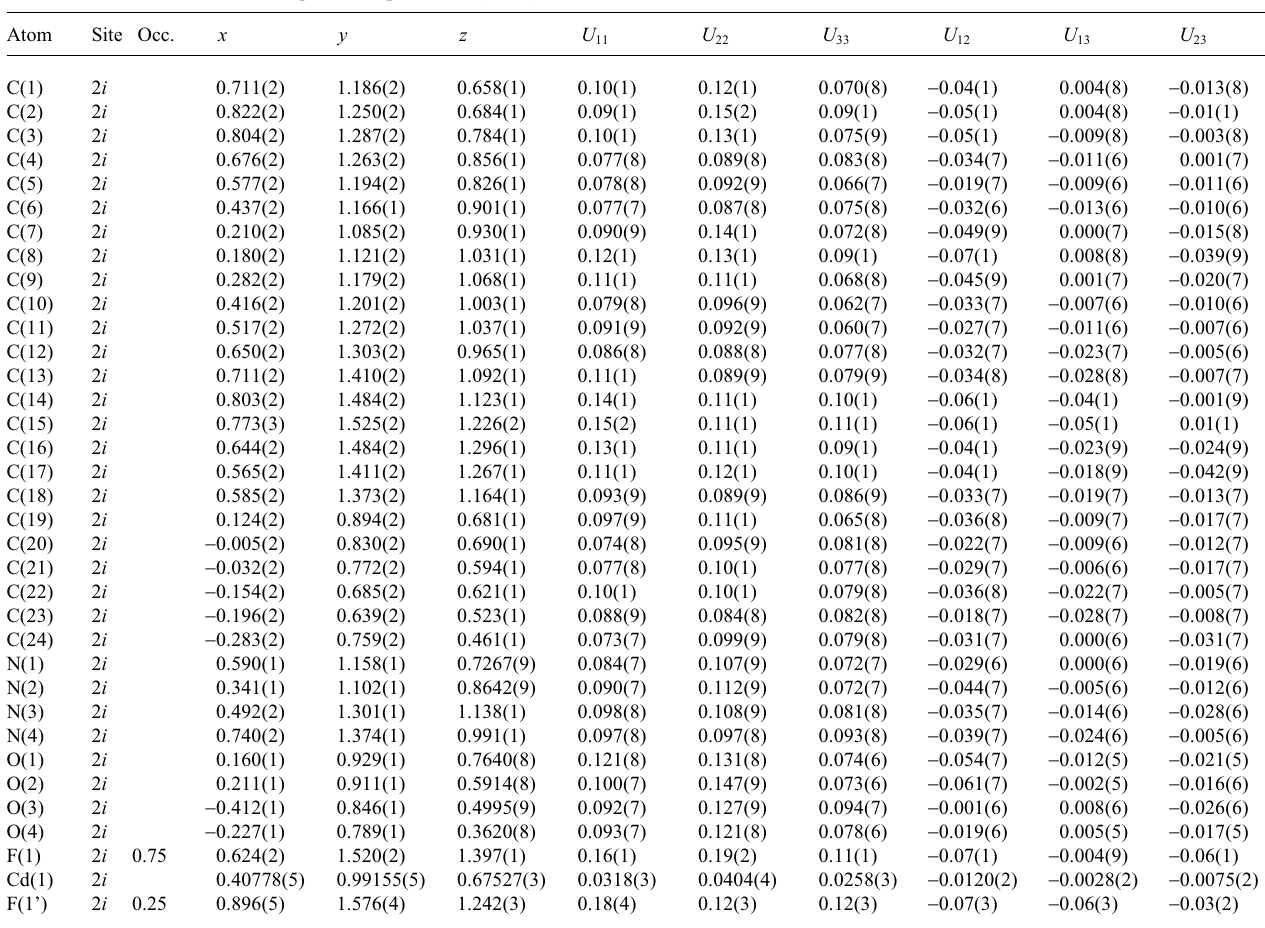
Table 3. Atomic coordinates and displacement parameters (in Å 2